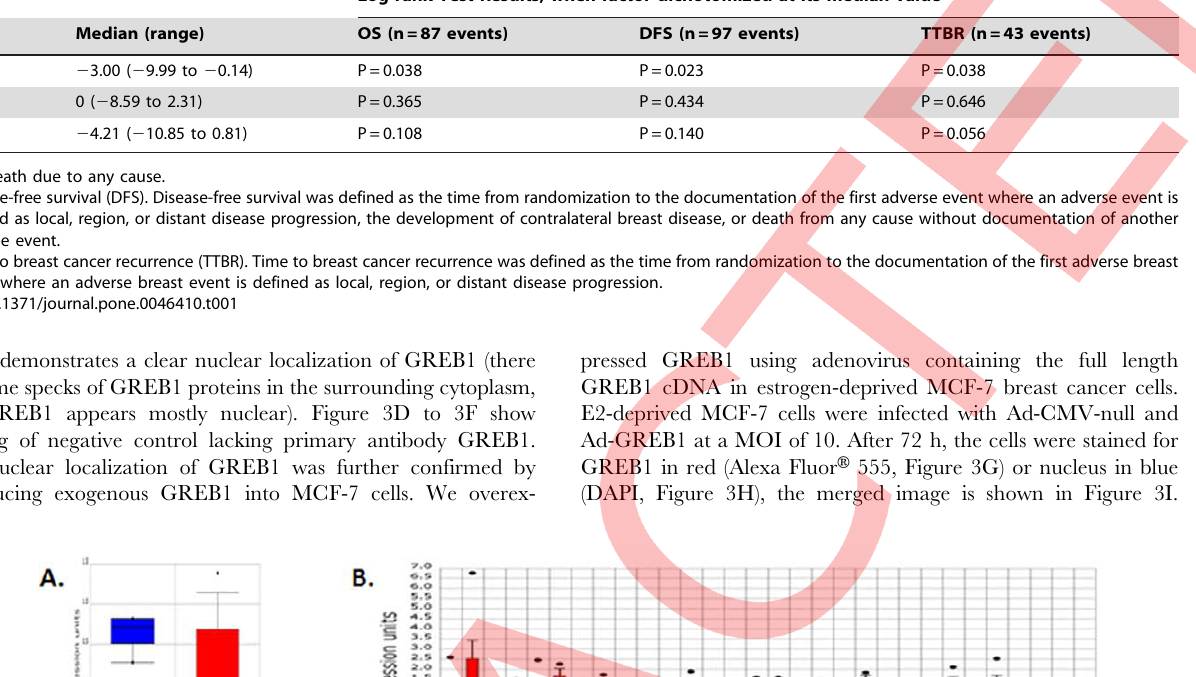
Log-rank Test Results, when factor dichotomized at its median value